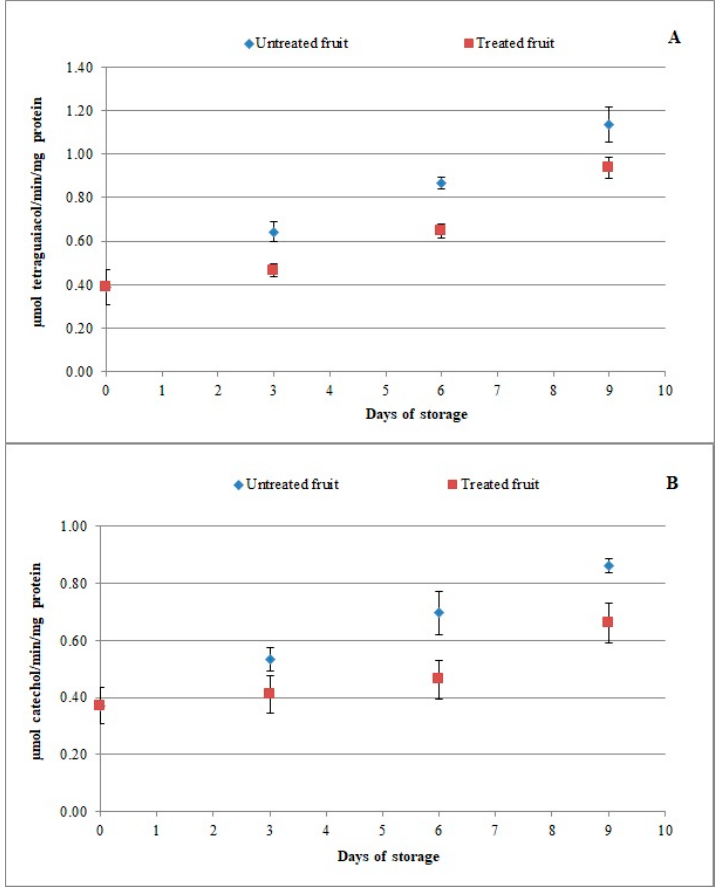
Figure 2. Activity of guaiacol peroxidase (GPX) ( A ), polyphenol oxidase (PPO) ( B ) in uncoated (untreated) and chitosan-based coated figs (treated fruits) at harvest (0) and after three, six and nine days of cold storage at 4 °C. Error bars indicate standard deviation.